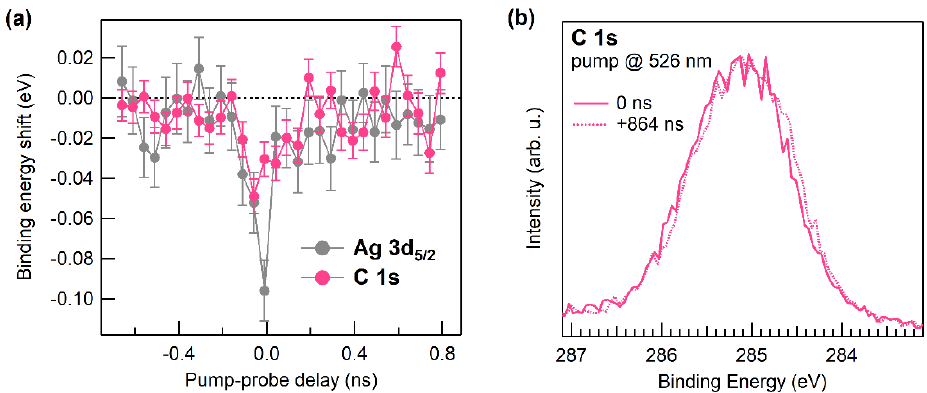
Figure 3. ( a ) Measured binding energy shift (Gaussian fit to the Ag 3d and C 1s lines) as a function of pump–probe delay time. Error bars represent one standard deviation. ( b ) C 1s XPS spectra measured at time zero (solid) and at 864 ns (dotted), i.e., with the second hybrid pulse after the pump, on PTCDI/Pc/Ag(111) after aligning the Ag 3d 5/2 peak to 368.3 eV. The C 1s core level line shifts towards higher binding energy within the first 50 ps.